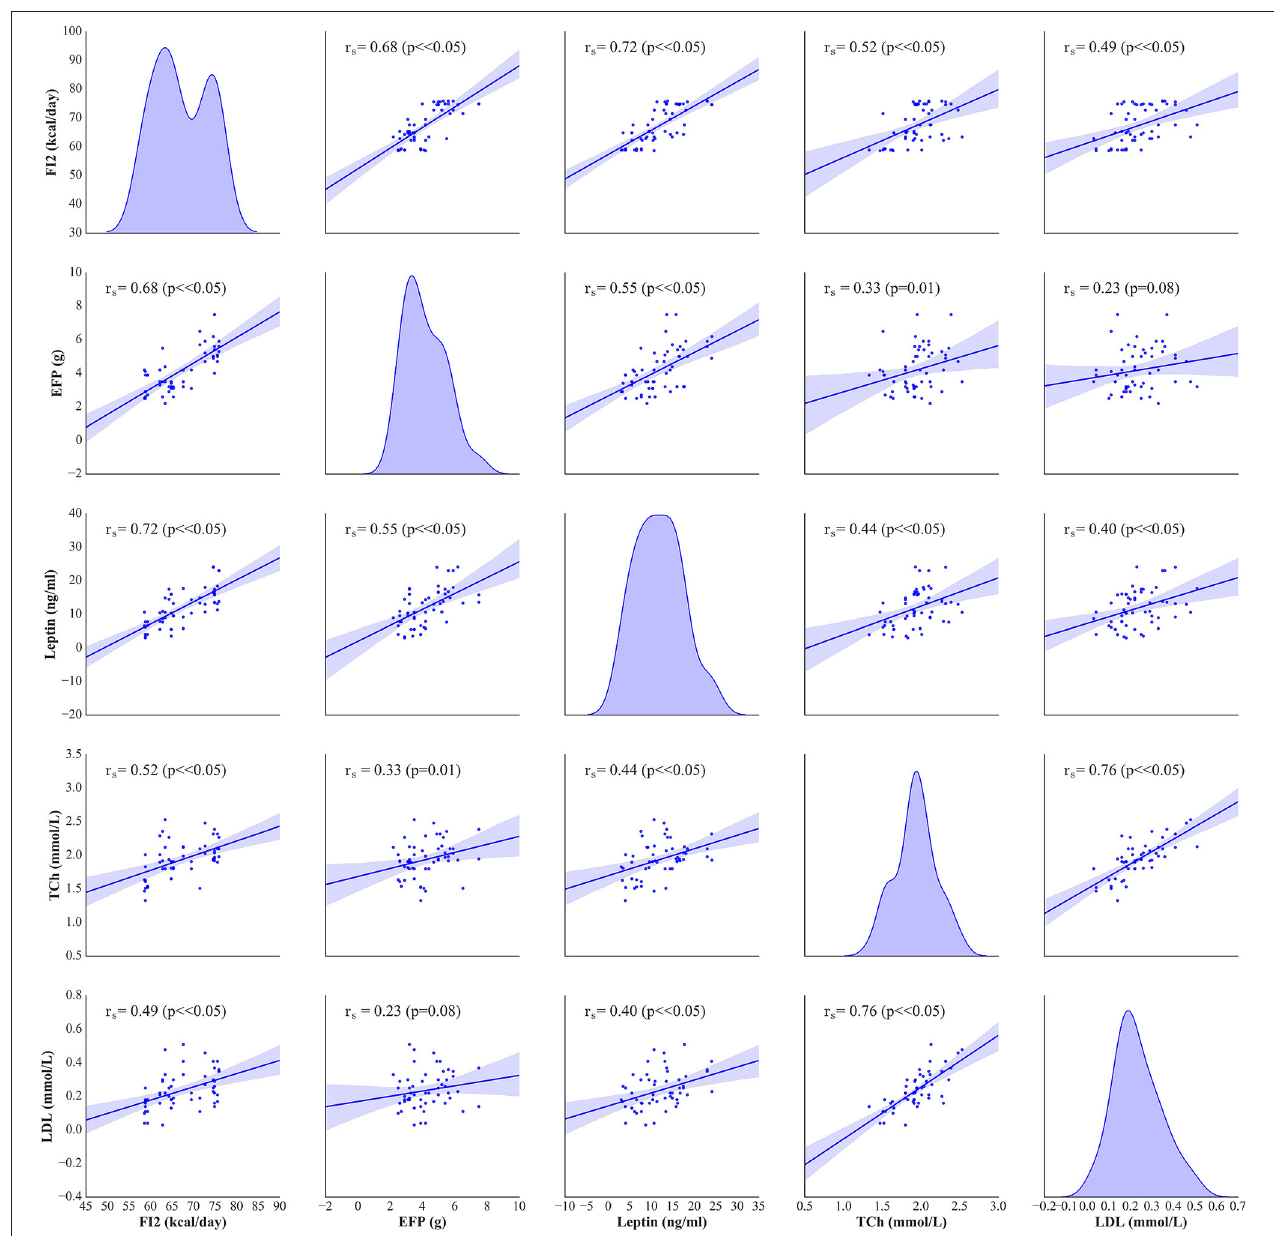
FIGURE 4 | Spearman’s correlation between the average food intake (FI2) [kcal/day], epididymal fat-pads (EFP) [g], serum leptin [ng/ml], total cholesterol (TCh) [mmol/L] and LDL [mmol/L] levels. On the diagonal of the multiple pairwise bivariate distribution plot, the kernel density estimate of the probability density function is shown for each variable subjected to the correlation